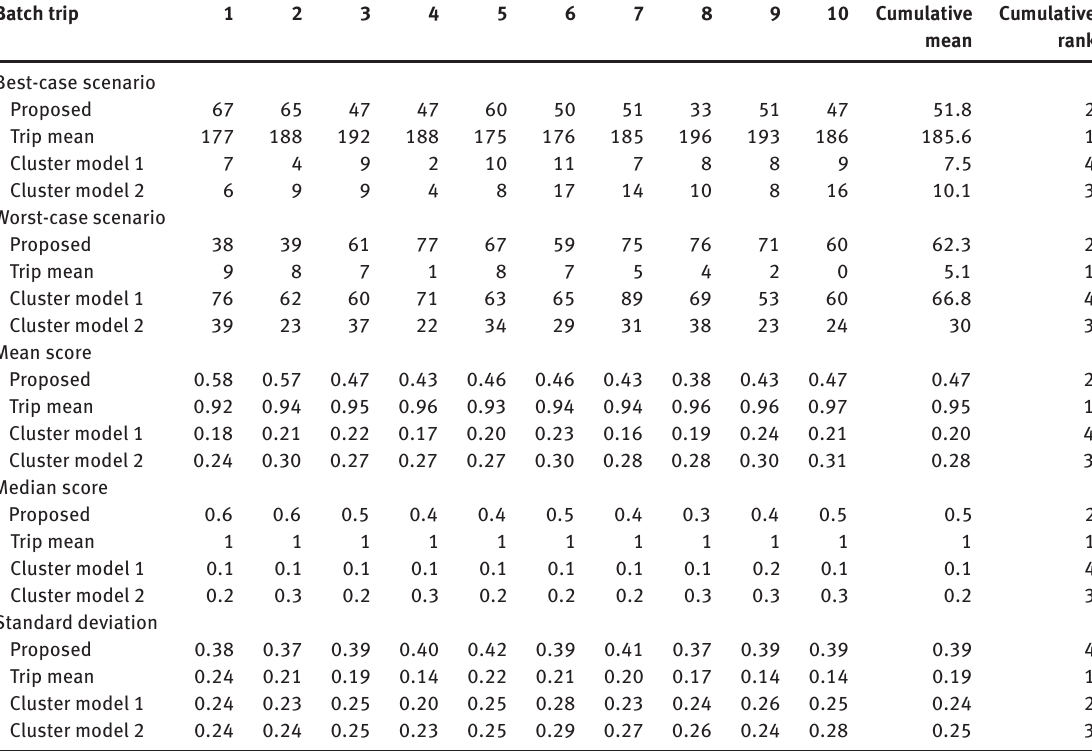
Table 5: Statistical Report on Trip Planning Models for 50%